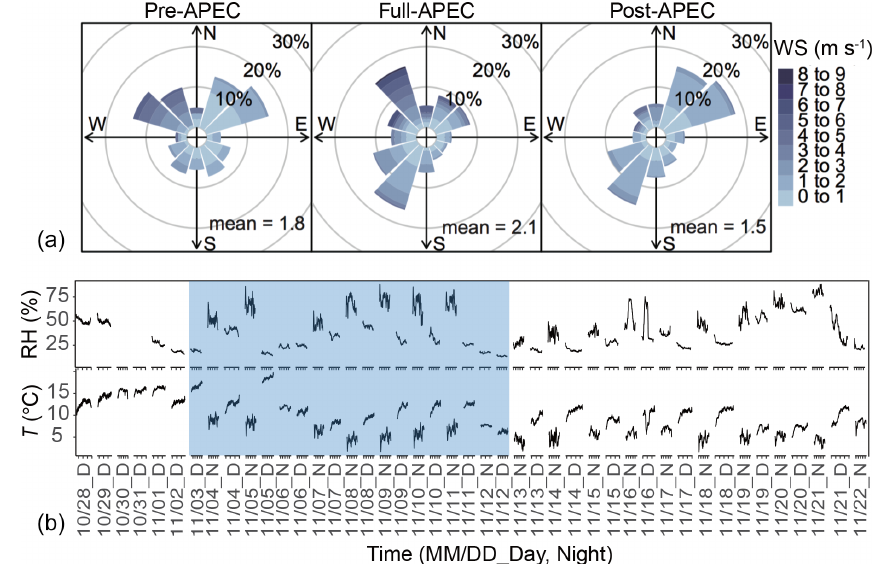
Figure 2. (a) Rose plots of wind direction (WD) and wind speed (WS) measured at the Nanjiao site during the pre-APEC (24 October to 2 November 2014), full-APEC (3–12 November 2014), and post-APEC (12–22 November 2014) periods. (b) Time series of the on-road observed temperature ( T ) and relative humidity (RH) during the observation period; the shaded blue area indicates the full-APEC period. APEC refers to the 2014 Asia-Pacific Economic Cooperation